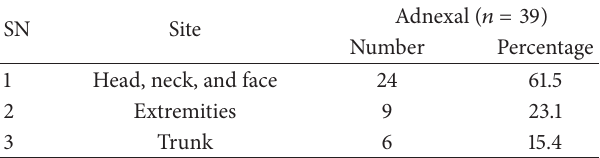
Table 2: Site/location of adnexal tumours.